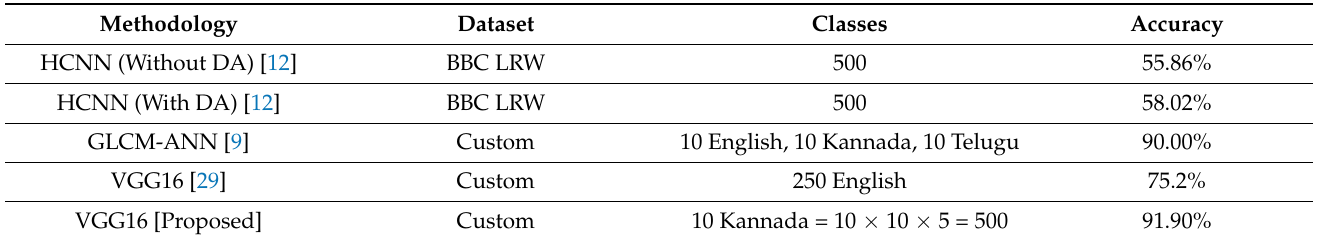
Table 5. Comparison of Proposed Methodology with other